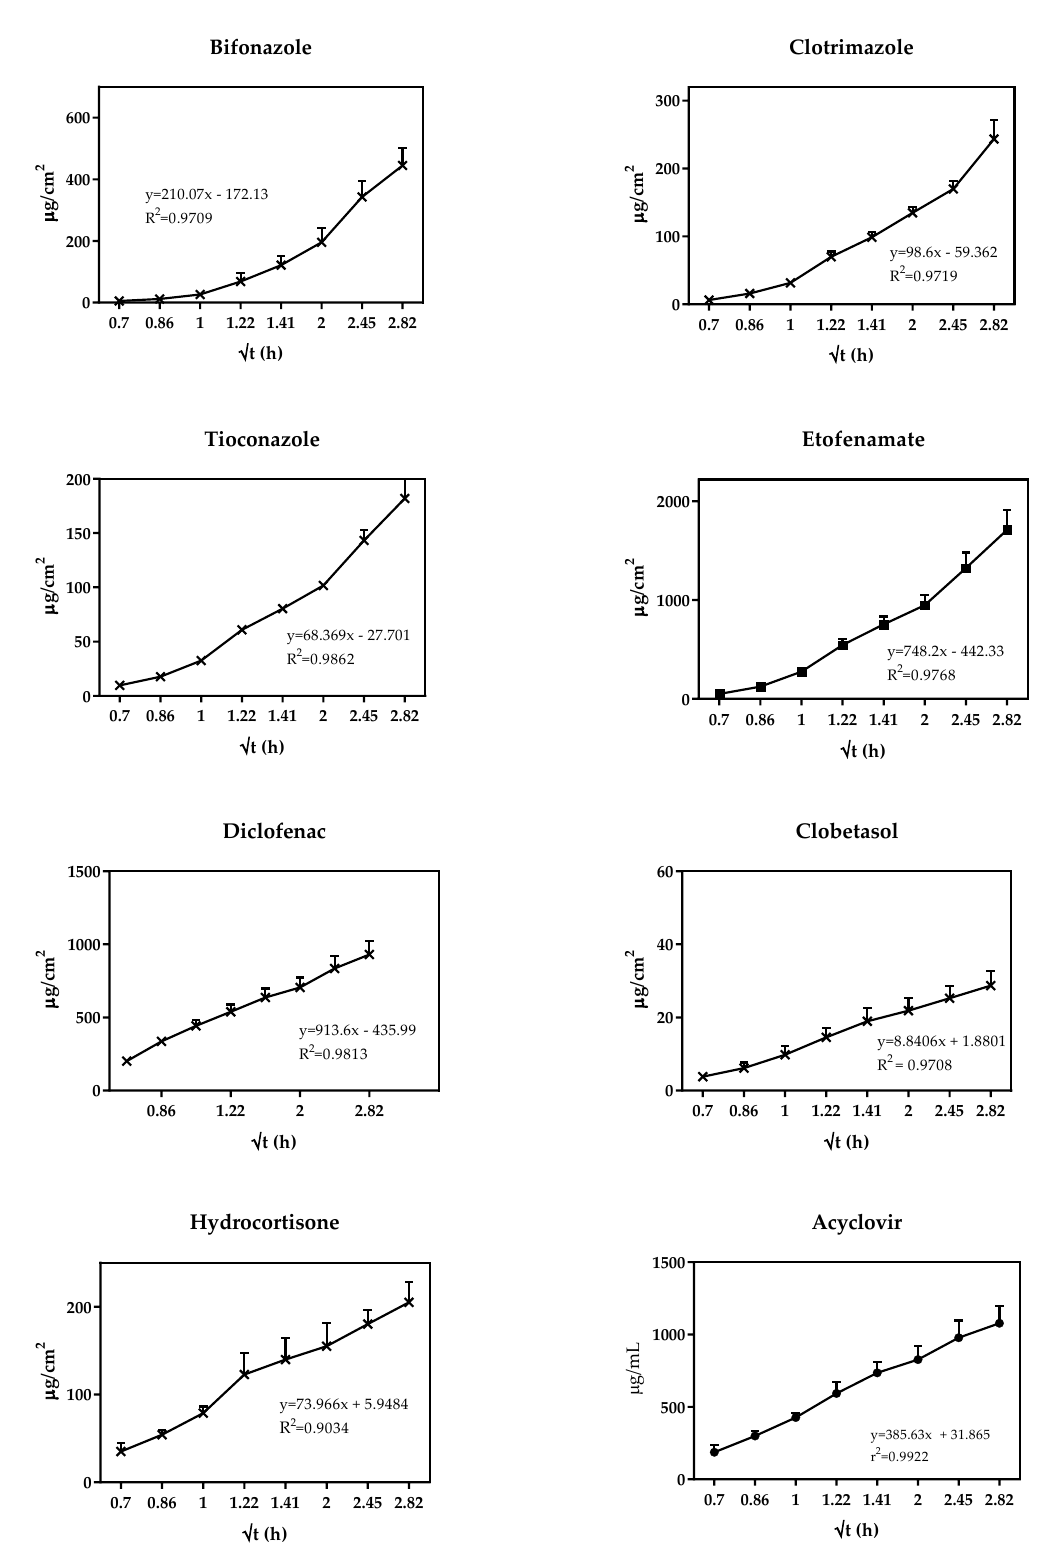
Figure 3. IVRT profiles of the studied products. Results are expressed as mean ± SD (n = 12).